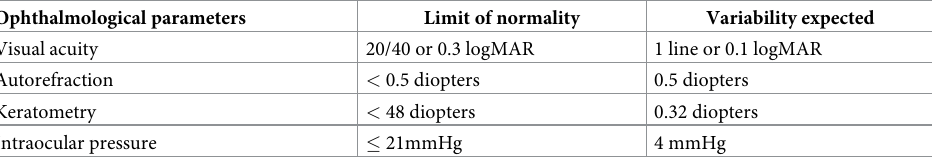
Table 1. Limits of normality and expected variability for the ophthalmological parameters